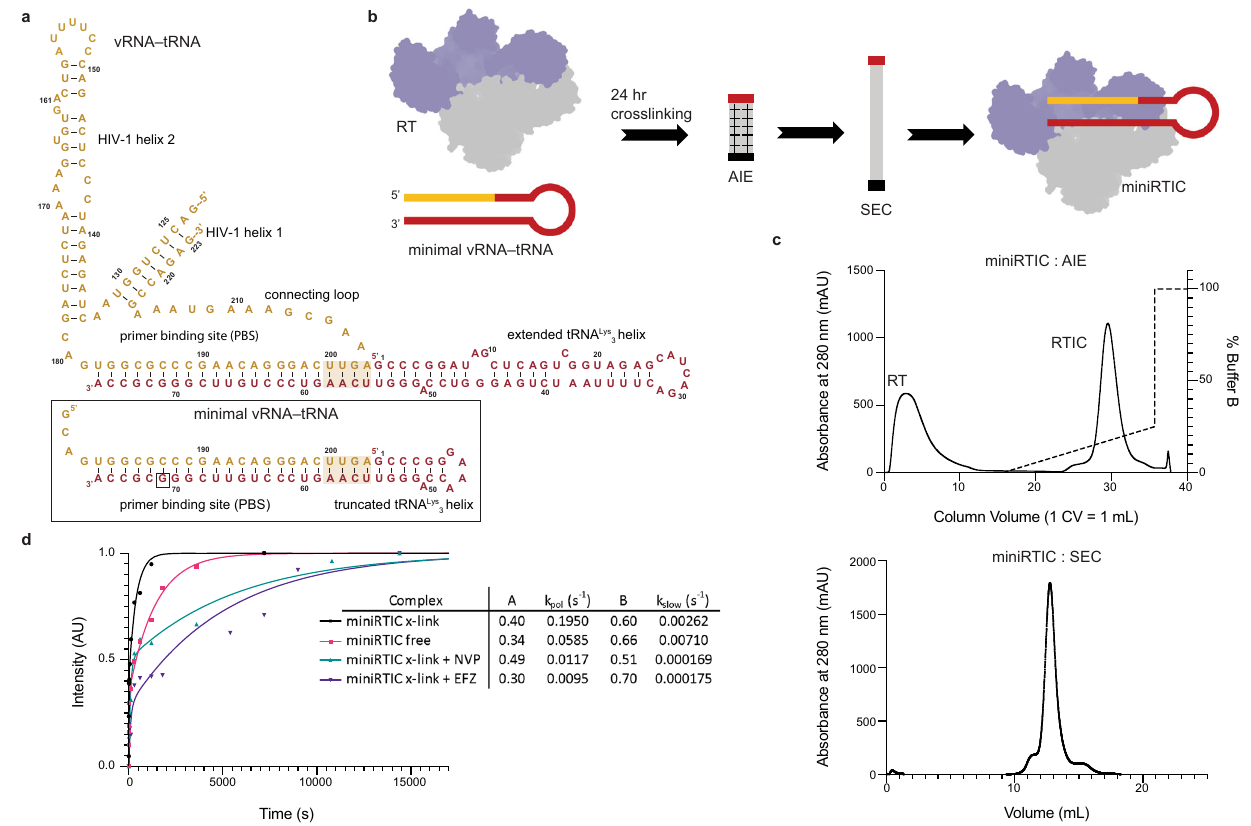
Fig. 1 RTIC construct design, puri fi cation, and validation. a Secondary structure of the vRNA – tRNA (gold-red) from Larsen et al. 12 (upper). The minimal bimolecular vRNA – tRNA template – primer (gold – red) construct (lower, boxed) was designed to encompass 4 nucleotides of single-stranded template vRNA, 22-bp of extended PBS helix, and 6 bp of tRNA primer capped with a GNRA loop; fl exible RNA regions in the vRNA – tRNA from Larsen et al. 12 were excluded from the minimal vRNA – tRNA. b The miniRTIC (p66 subunit in purple; p51 subunit in gray) was formed by cross-linking RT and the minimal vRNA – tRNA for 24 h and puri fi ed by subsequent anion-exchange (AIE) and size-exclusion chromatography (SEC). c AIE and SEC chromatograms of the miniRTIC puri fi cation process. d Functional analysis of cross-linked (x-link) and un-cross-linked (free) miniRTIC. Incorporation assays of free miniRTIC (pink), x-link miniRTIC (black), x-link miniRTIC with 50 nM nevirapine (NVP, green), and x-link miniRTIC with 50 nM efavirenz (EFZ, purple) were initiated (cid:1) (cid:3) þ B ð 1 (cid:2) e (cid:2) k slow t Þ , where A by addition of α - 32 P-dCTP and quenched at different time points. Data were fi t using the relationship: Intensity ¼ A 1 (cid:2) e (cid:2) k pol t and B represent the amplitude of the fast and slow processes, respectively, k pol is the apparent extension rate constant, and k slow is the rate of the slow process. k pol is ~3.3-fold faster for the x-link miniRTIC than for the free miniRTIC. Assays for the x-link miniRTIC and free miniRTIC were each repeated fi ve times. NVP and EFZ conditions were each repeated three times to ensure reproducibility.